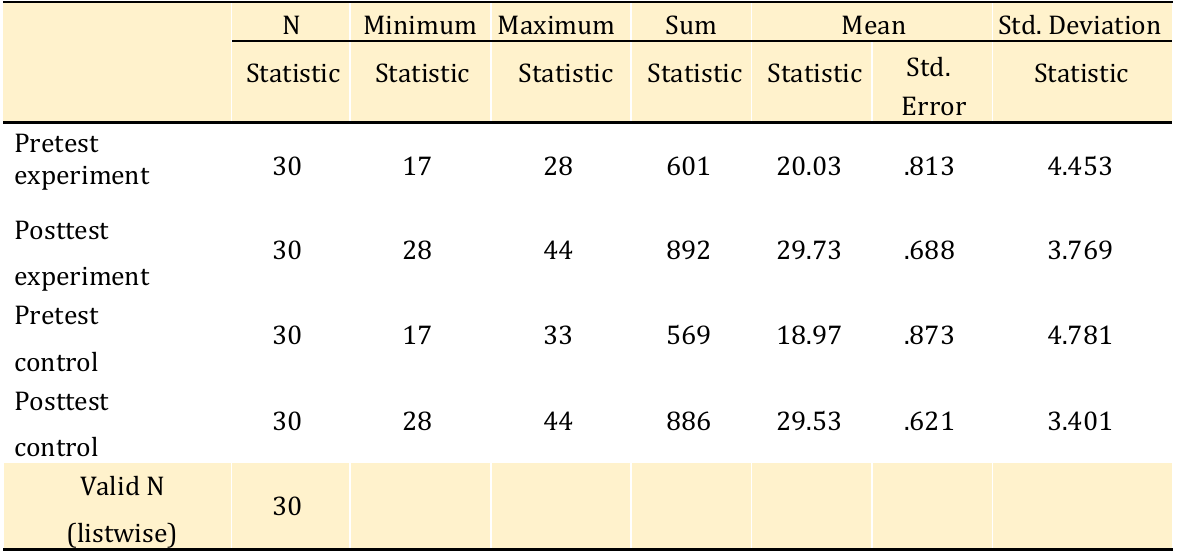
Table 10. The t-test of Pretest for both